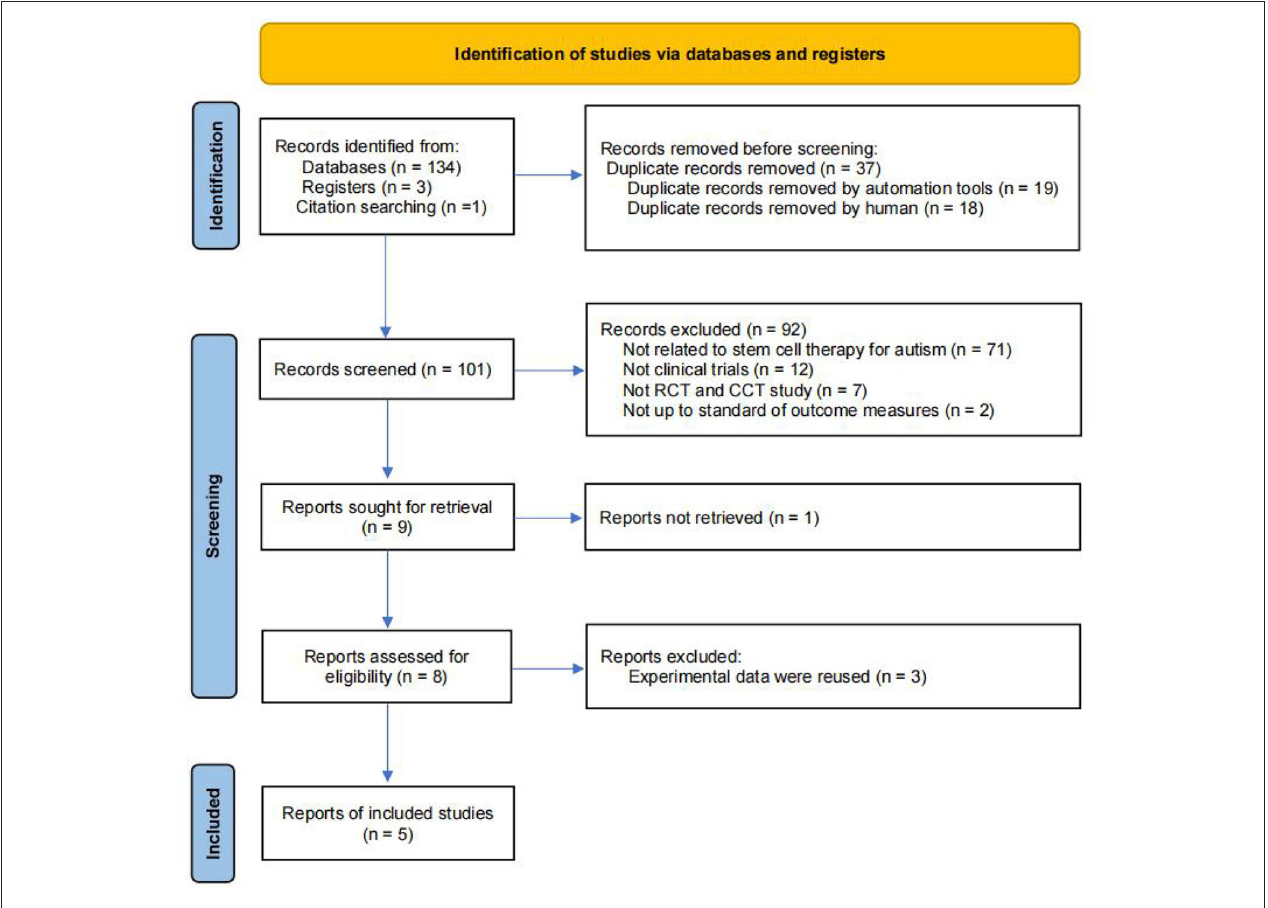
FIGURE 1 | The inclusion flow chart of the literature was